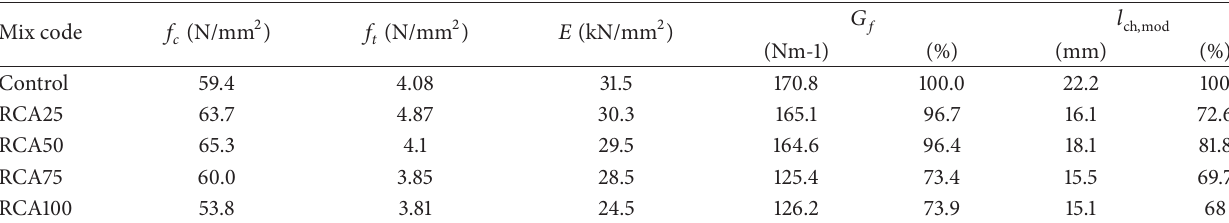
Table 5: Fracture properties test results.